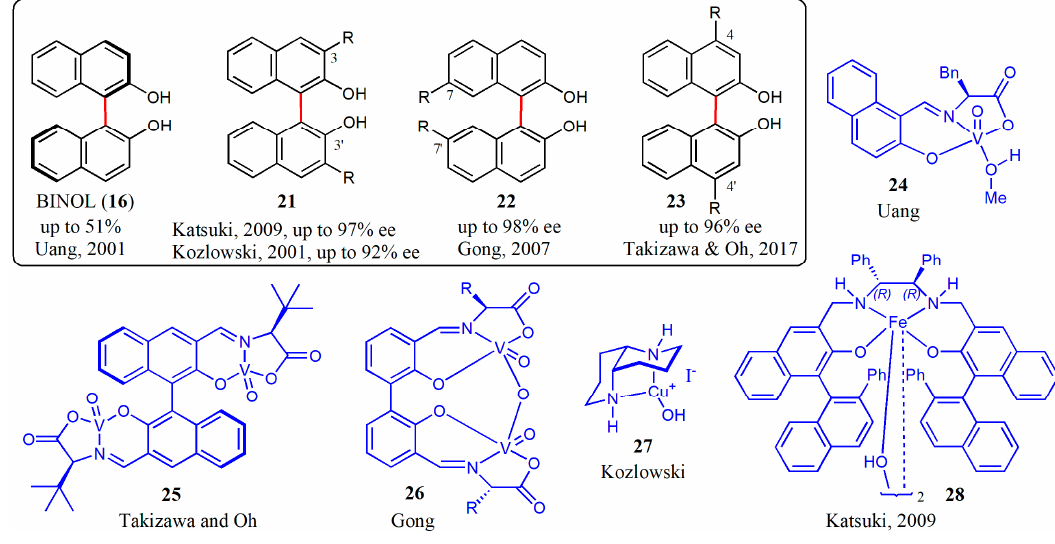
Figure 9. Optically stable BINOLs 16 and 21–23 .